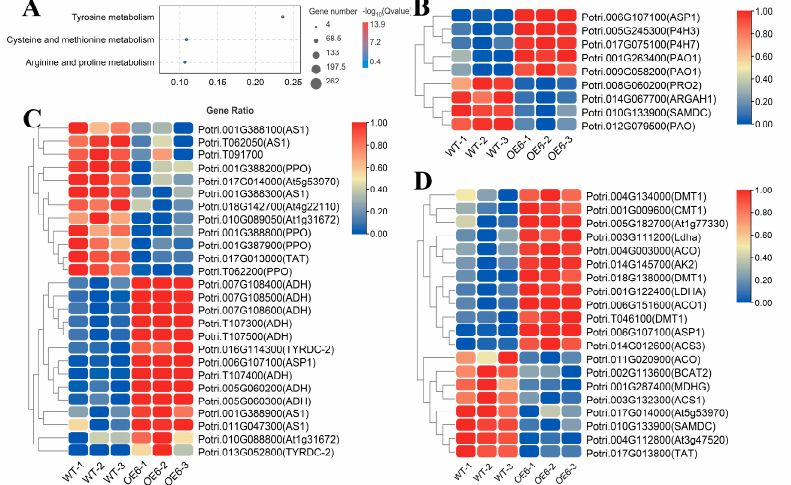
Figure 8. Results of RNA-Seq for amino acid transport. ( A ) Results for the Kyoto Encyclopedia of Genes and Genomes (KEGG) enrichment about amino acid. Heatmap for differentially expressed genes DEGs for the amino acid pathway of arginine and proline metabolism ( B ), tyrosine metabolism ( C ), and cysteine and methionine metabolism ( D ), respectively.